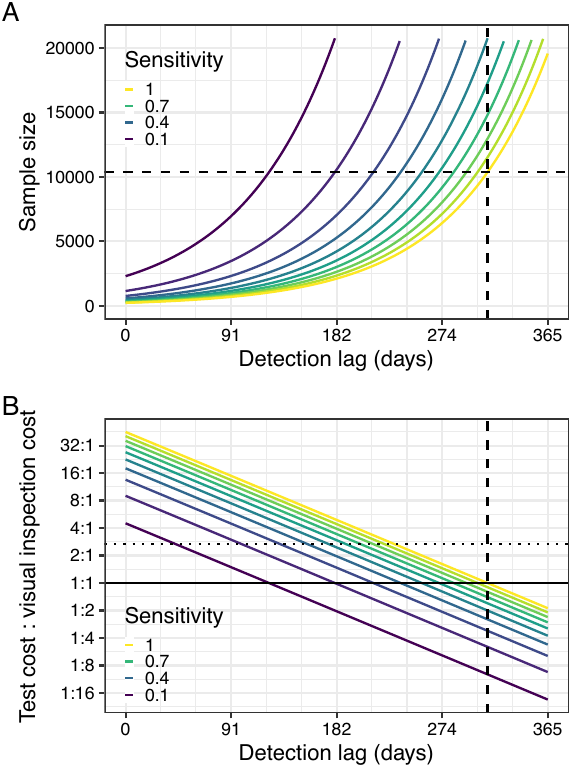
Figure 5. The low sensitivity of current diagnostic tests when applied to presymptomatic hosts may limit their ability to detect infections at a low prevalence. ( A ) Diagnostic tests can result in a lower sample size than visual inspection, but if the diagnostic sensitivity is low, the test needs to be able to detect infection shortly after infection. This plot shows the impact of reducing the detection lag and the diagnostic sensitivity on the number of hosts which must be found to be negative to be 90% confident that the prevalence is lower than 1% (the sample size). As the dashed lines reflect the detection lag and required sample size under visual inspection, all solid lines below the horizontal dashed line indicate that fewer trees must be tested to declare pathogen freedom than would have to be visually inspected. ( B ) Lower detection sensitivities and higher costs both reduce the feasibility of a nonvisual detection method, even if the detection lag is short. This plot expands on plot A to also incorporate testing costs. We capture this by showing in solid coloured lines the relative cost of an alternative detection method at which the total costs of surveillance would be equal to those under visual inspection, for different diagnostic sensitivities. The intersections of the solid coloured lines with the solid black line (which indicates that the costs of the detection method is equal to that of visual inspection) therefore represent equal required sample sizes (and therefore match the intersections of the curves in plot A with the dashed line in that plot). The horizontal dotted line indicates the current estimated relative cost of using the host ELISA test (a cost ratio of €14.63/€5.48 = 2.67). The vertical dashed line shows the presymptomatic period for X. fastidiosa (and therefore the detection lag for visual inspection). All areas of the parameter space below the test sensitivity contour of interest indicate that the alternative detection method is cheaper to deploy than visual inspection, and all areas above indicate that visual inspection is